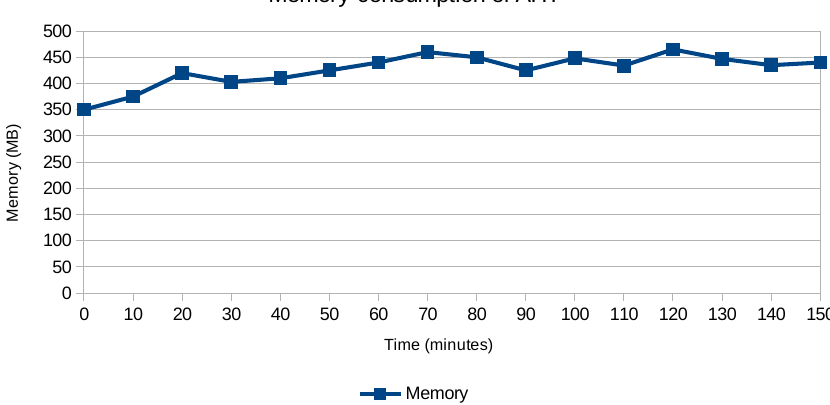
Figure 16. Time required before sharding becomes